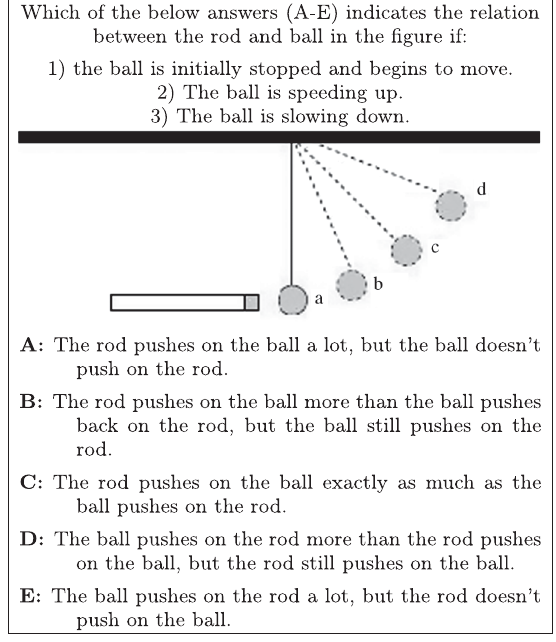
FIG. 4. Phase1promptandresponseforN3LtaskforE&M.The students were asked to compare the forces on the rod and ball for the three scenarios where the ball started to move, sped up, slowed down, and at rest at the apex of the swing. As in the mechanics example, the forces in each case are equal and